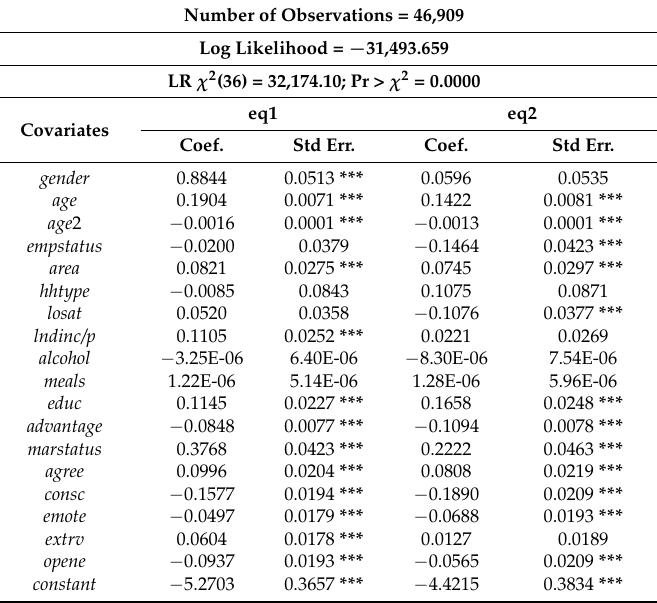
Table A2. Estimates for the unrestricted generalized order